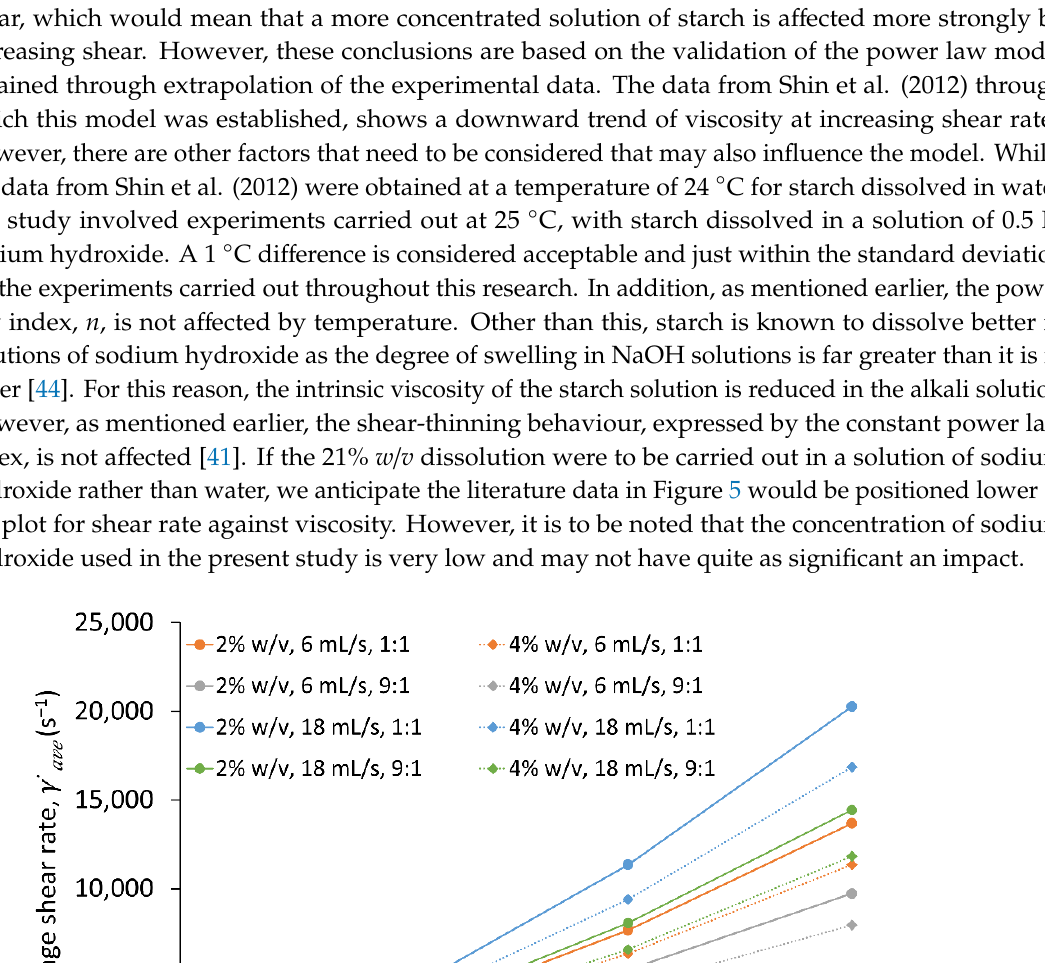
Figure 8. E ff ect of disc rotational speed on shear rate at various experimental Figure 8. Effect of disc rotational speed on shear rate at various experimental conditions.